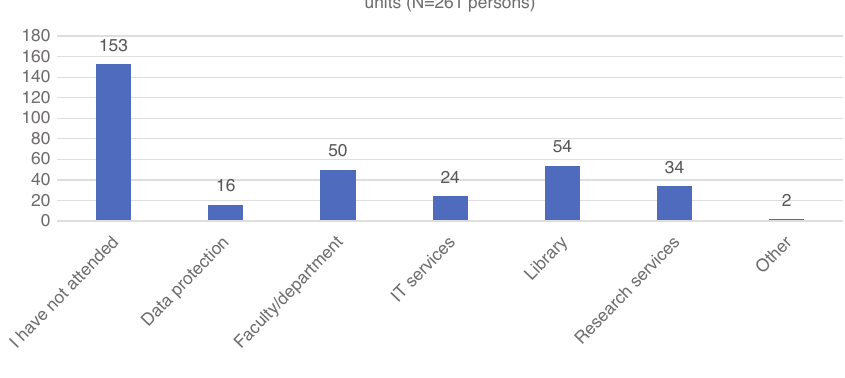
Fig. 5: Training providers (N=261 persons).